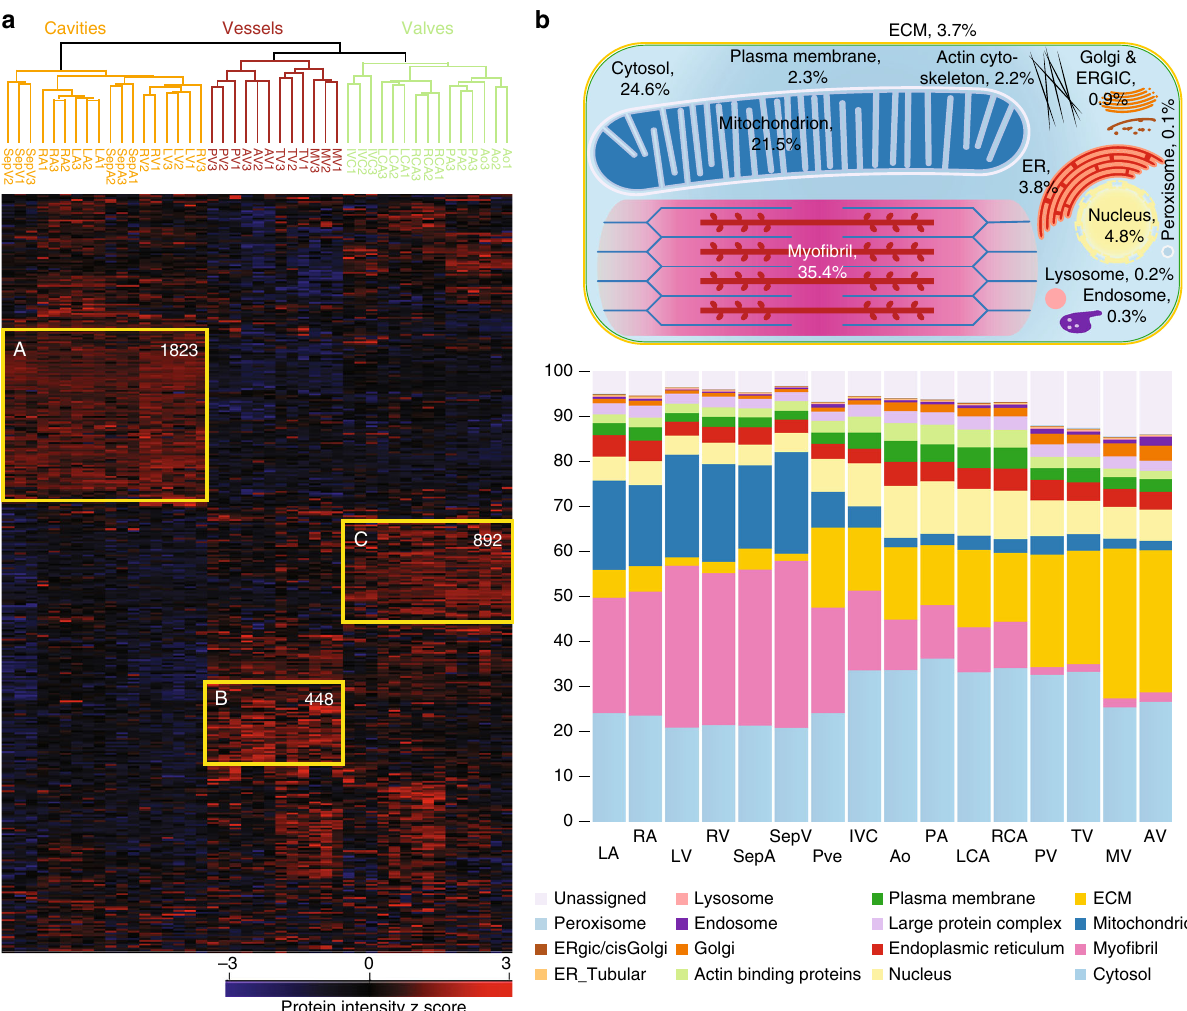
Fig. 3 Proteins differentially expressed across the different heart areas. a Heat map of z-scored protein abundances (LFQ intensities) of the differentially expressed proteins (ANOVA, FDR < 0.05) after unsupervised hierarchical clustering reveals proteins signi fi cantly upregulated in the cavities, vessels, or valves (highlighted in yellow: A, B, and C). b The upper panel shows a schematic of an average heart cavity cell, where organelles are sized according to their contribution to total protein mass. Percentages are taken from the median of all cavities and scaled to account for unassigned proteins. The lower panel shows the contribution of each organelle to cellular protein mass, as a percentage of the total, in each heart